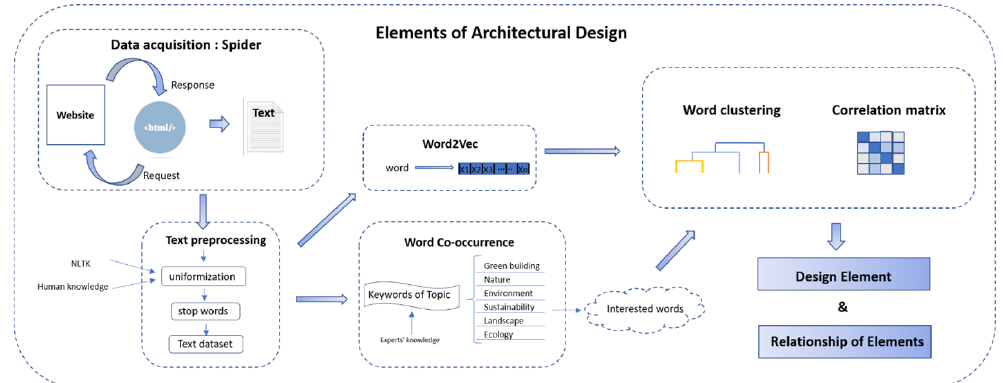
Figure 1. The research